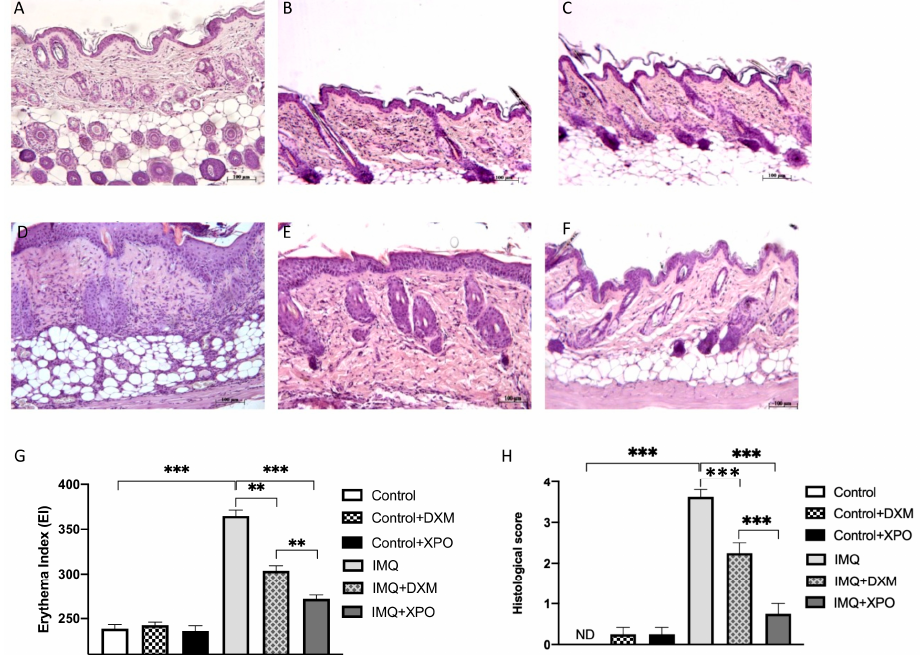
Figure 5. Effects of XPO cream on histological damage induced by imiquimod (IMQ) and erythema evaluation. Extensive damage to the epidermis was evaluated in IMQ-treated mice (panel ( D )). Administration of DXM reduced tissue damage caused by IMQ (panel ( E )) compared to the control group (panel ( A ). Topical treatment of DXM ( C ); Topical treatment of XPO ( B ); Topical treatment of XPO cream significantly reduced histological damage induced by IMQ (panel ( F )); see histological score ( H ). IMQ treatment increased erythema and the thickness of skin in psoriasis-like mouse model compared to control group ( G ). However, mice treated with XPO cream by topical administration revealed markedly reduced erythema in the lesioned flank, with higher efficacy compared to DXM ( G ). *** p < 0.001; ** p < 0.01; ND: not detectable.